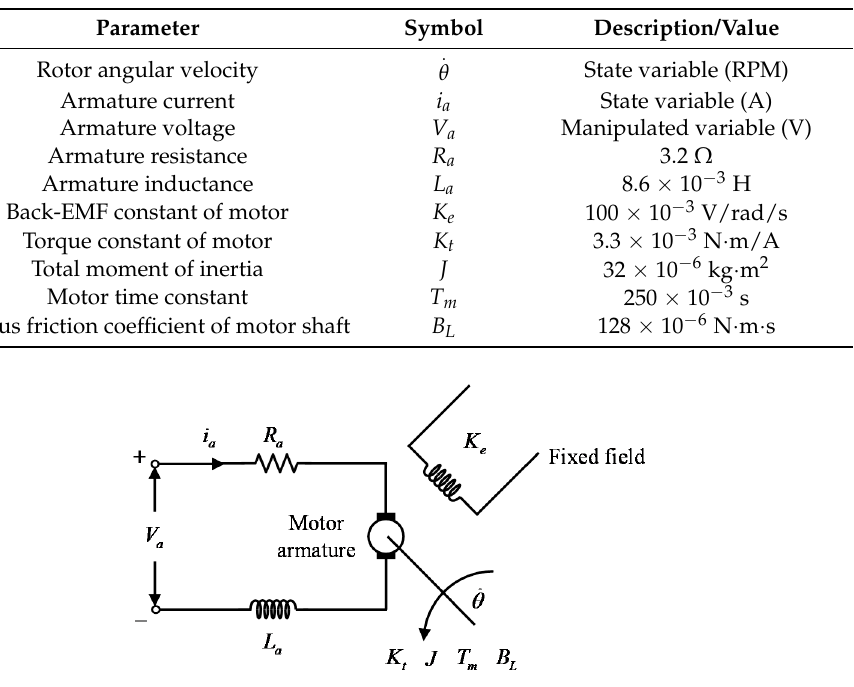
Table 1. Notation and parameter values for the DC motor.